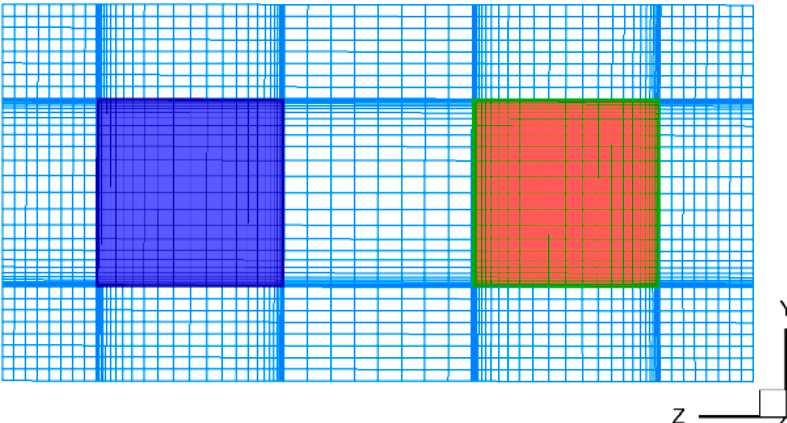
Figure 3. Cross-section of the grids.